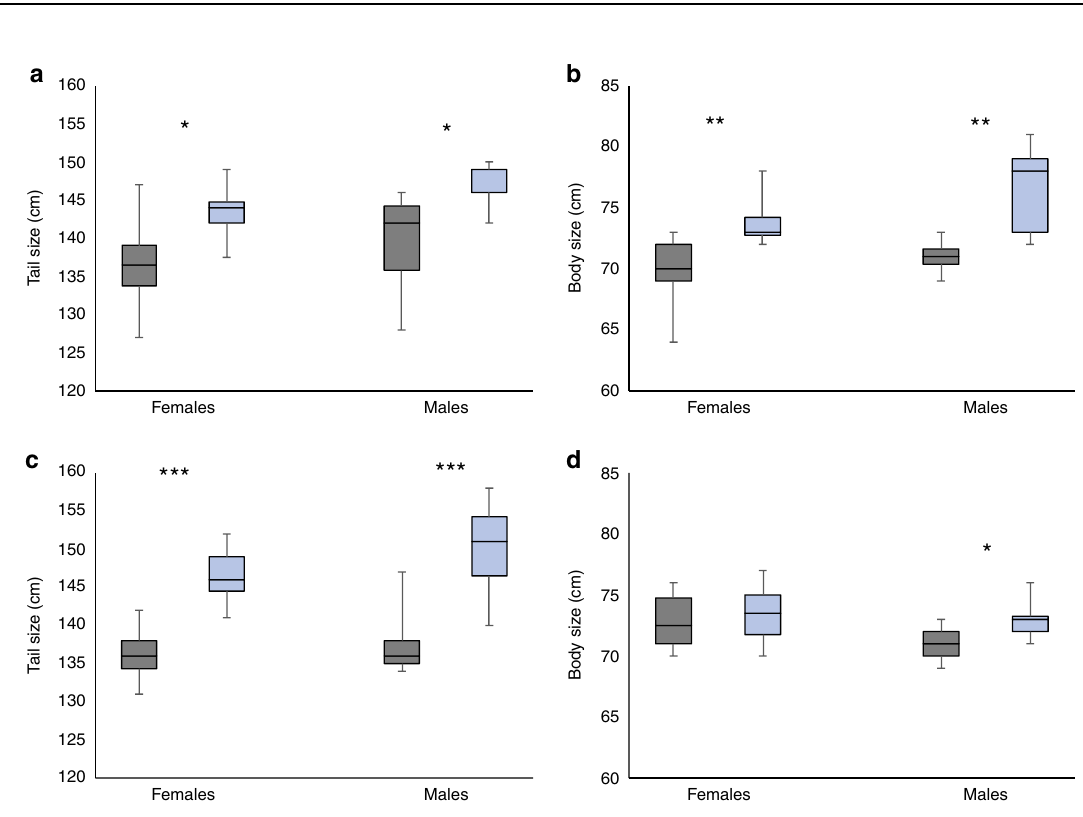
Fig. 2 Size differences between hybrid and non-hybrid females and males. Box plots of tail and body size for new adults in 2012 ( a , b ) and 2013 ( c , d ). The rectangle spans the fi rst to third quartile, the segment inside the rectangle represents the median, and the whiskers above and below show the maximum and minimum value. Grey boxes are non-hybrids and light-blue boxes are hybrids. Signi fi cant differences, as assessed by ANOVA, between hybrids and non-hybrids are indicated (* P < 0.05, ** P < 0.01, *** P < (Table 2). This heterotic effect may re fl ect fi tness consequences of inbreeding in the Mount Buller population; there was a 76% drop in heterozygosity between 1996 and 2010, which equates to an effective population size of 3.88 (95% CIs; 1.81 – 8.05) during this period and led to detectable inbreeding (see “ Methods ” section).